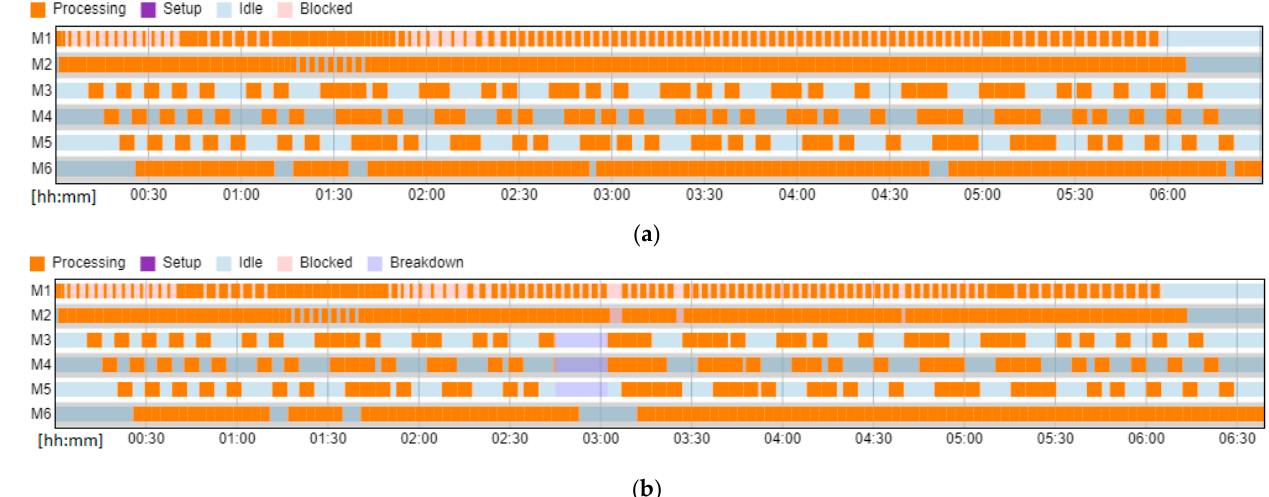
Figure 10. The Gantt chart of the best schedule achieved by the FlexSim ( a ) without and ( b ) with predictive maintenance.